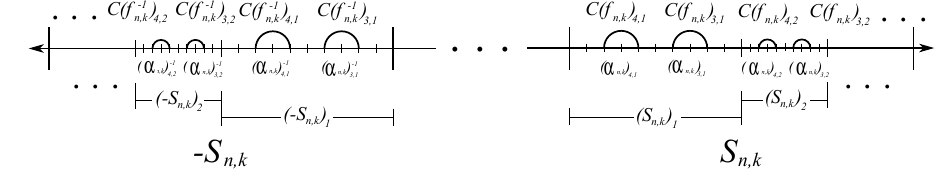
Figure 16: The closed intervals S n , k and − S n , k